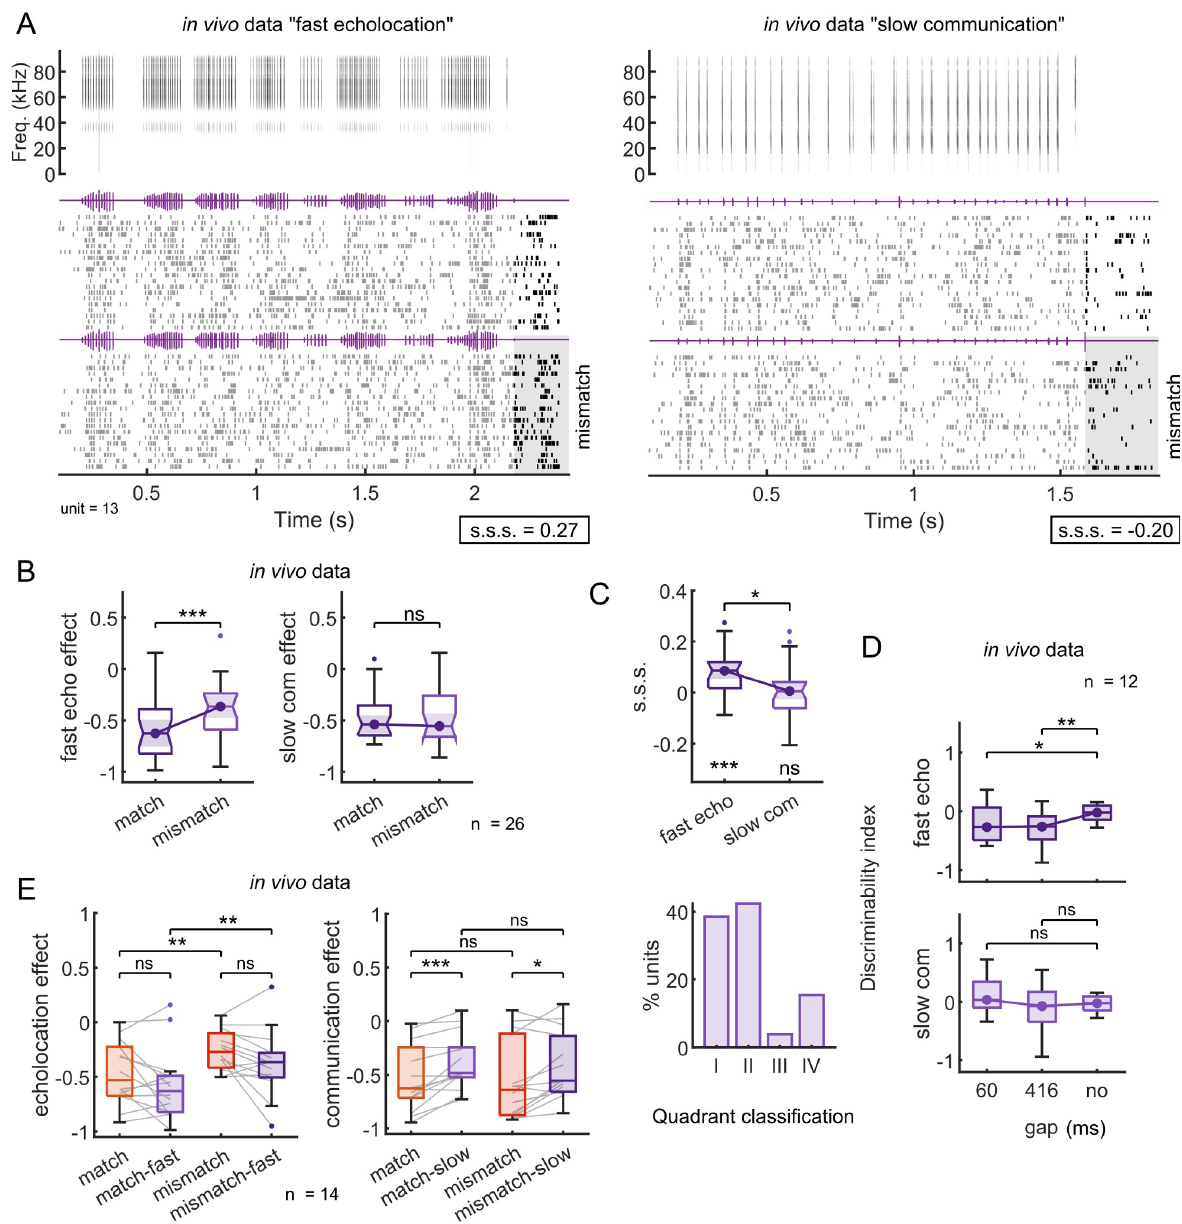
Fig 9. Switching the temporal patterns between contexts does not change the effect on probe-responses under anaesthesia. ( A ) Representative example unit firing in response to the context-probe paradigm using “chimera” sequences. Top left: spectrogram of a sequence of echolocation pulse following the temporal pattern of the communication call used as context (called “fast echolocation”). Top right: spectrogram of a sequence of communication calls with the temporal pattern of the echolocation sequence used as echolocation context (called “slow communication”). Below: the spiking responses to the respective sounds (context) followed by a matching probe sound (top 20 trials) and by a mismatching probe sound (bottom 20 trials). Probe sounds correspond to a single echolocation pulse and a communication call, respectively. The grey square is aligned to the onset of the last call that correspond to the mismatching probe sound in both cases. For each context, the respective value of stimulus-specific suppression (s.s.s.) is indicated. ( B ) Context effect after fast echolocation context (left) and after slow communication ( n = 26). ( C ) Top: Boxplots of s.s.s. per context. Significance level below the boxplot indicates differences against null distribution (one-sample Wilcoxon signed-rank test). Bottom: percentage of units per quadrant as showed in Fig 6A and 6B but for units recorded in response to stimuli showed in “A”. ( D ) Discriminability index calculated 60 and 416 ms after the offset of the fast echolocation context (top) and slow communication (bottom) and after no context. ( E ) Same units’ comparison ( n = 14) between natural temporal pattern context effect (red) and switched temporal pattern context effect (purple). Left: context effect after echolocation context; right: after communication context. All significance levels were obtained using the paired test Wilcoxon signed-rank. Data supporting panels B-E can be found in the files “all_data.mat,” “inj_data.mat,” “chi_data.mat,” “pt_data.mat,” and “all_ce.mat” in “Ephys data” folder in https://gin.g-node.org/Luciana/anesthesia_bats. The underlying codes for each panel are in the same location.